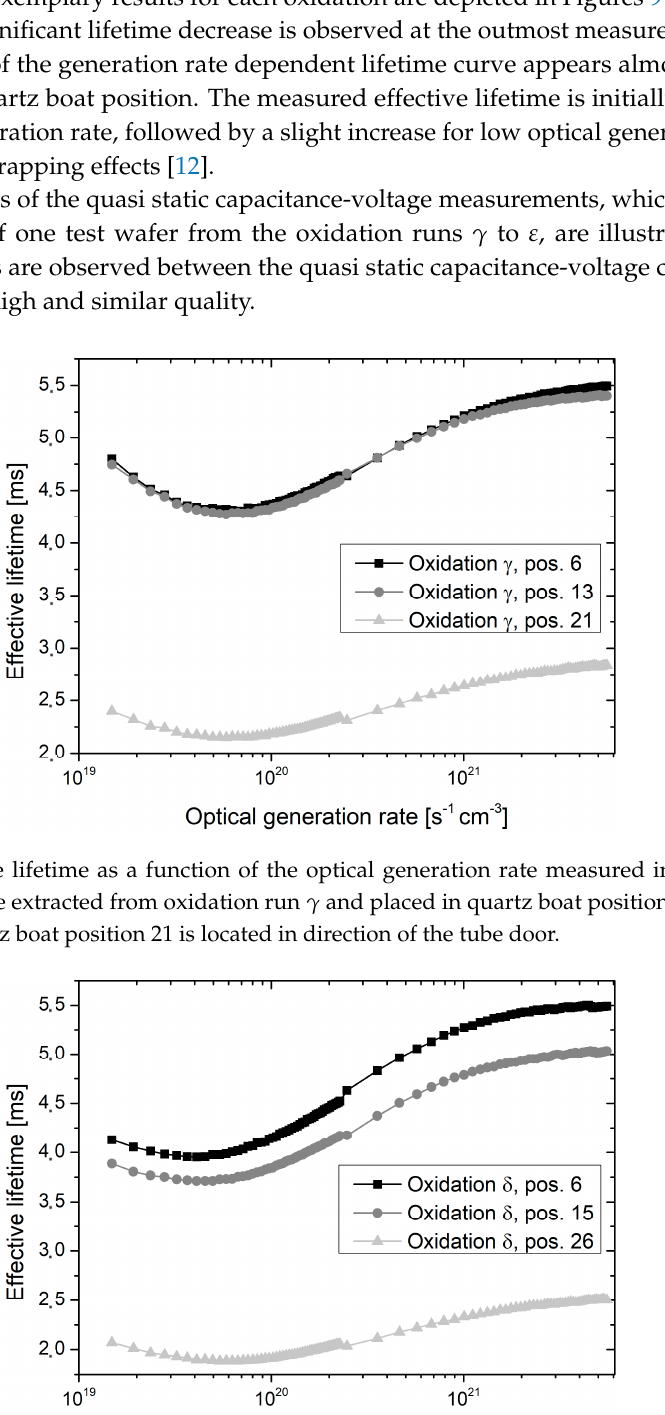
Figure 8. For oxidation run ε , effective lifetimes are shown as a function of quartz boat position and wafer number, respectively. The quartz boat positions 6–18 contained only 150 mm wafers from batch A, whereby quartz boat position 18 is located in direction of the tube door.